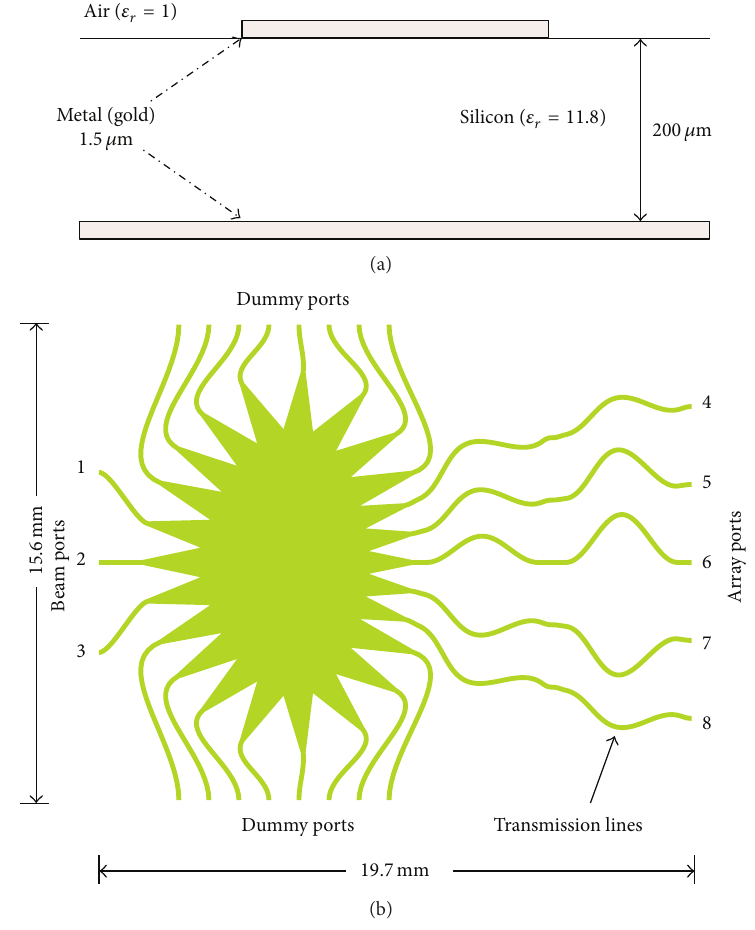
Figure 2: Rotman lens geometry. (a) Cross section. (b) Top view.